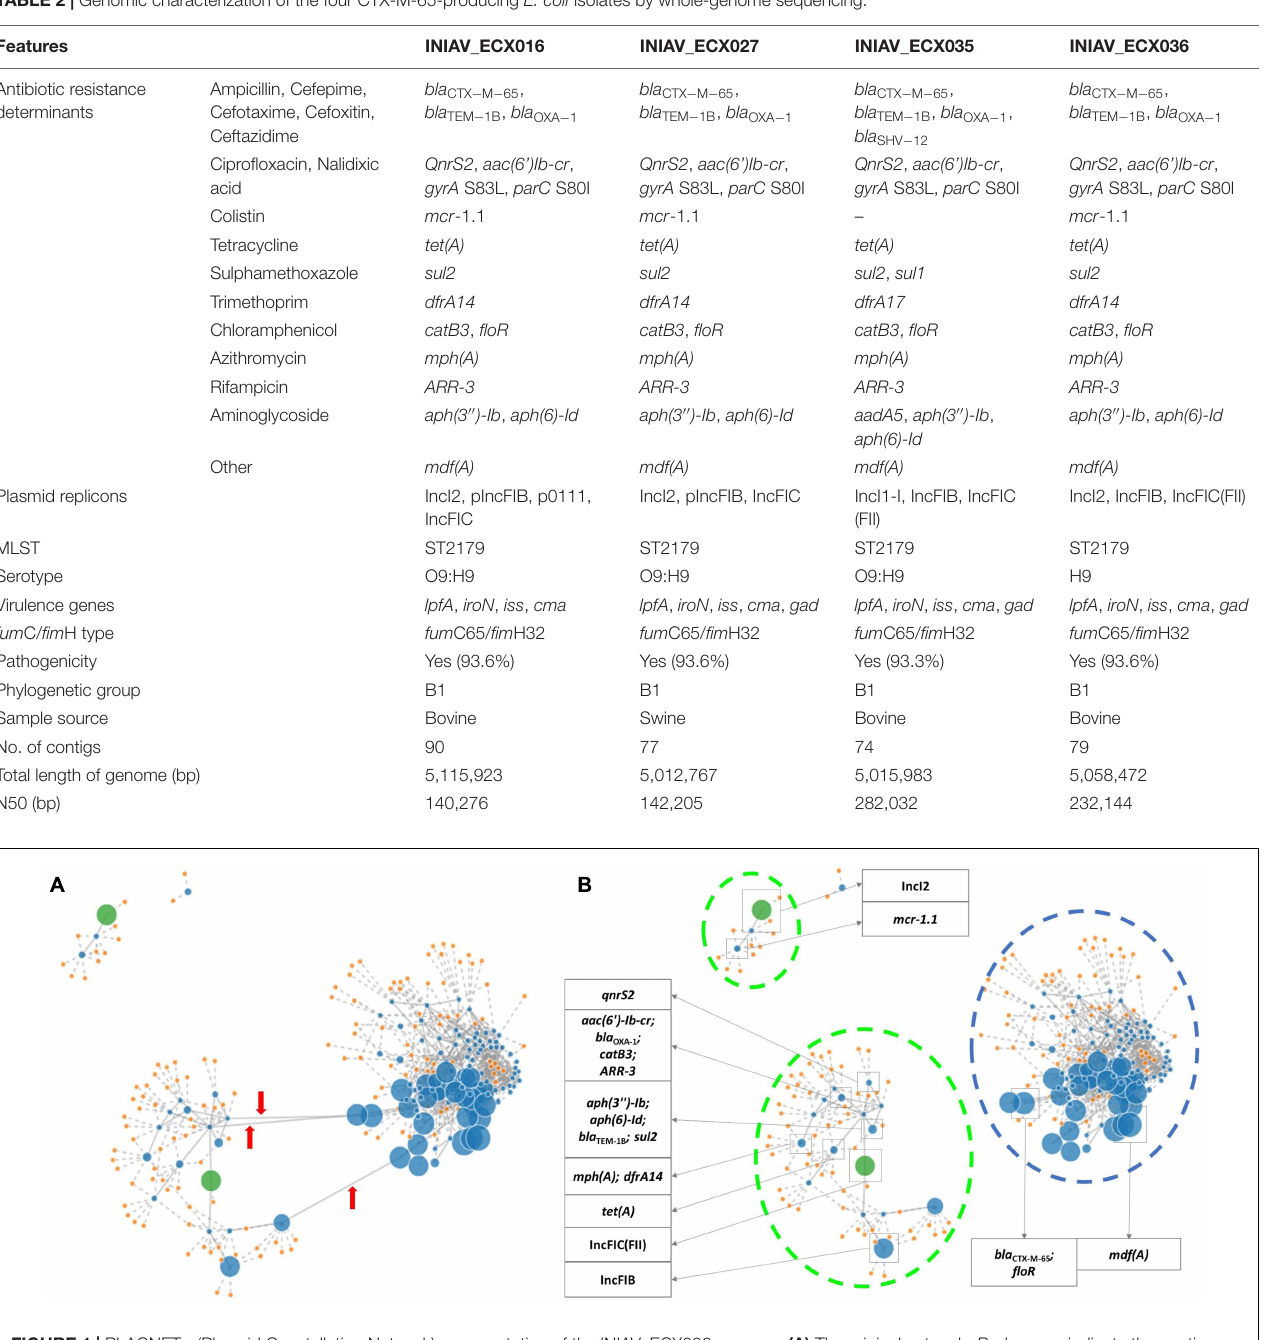
FIGURE 1 | PLACNETw (Plasmid Constellation Network) representation of the INIAV_ECX036 genome. (A) The original network. Red arrows indicate the contig linkages that were pruned. (B) The pruned network, where contigs containing the antimicrobial resistance genes and plasmids are identified according to ResFinder and PlasmidFinder. Blue dots indicate contigs (the dot size is proportional to the size of the contig); orange dots are the reference genomes from the tool database; green dots are contigs with relaxase and replicon protein of the plasmid; blue broken lines indicate contigs identified as chromosome; and green broken lines are contigs identified as